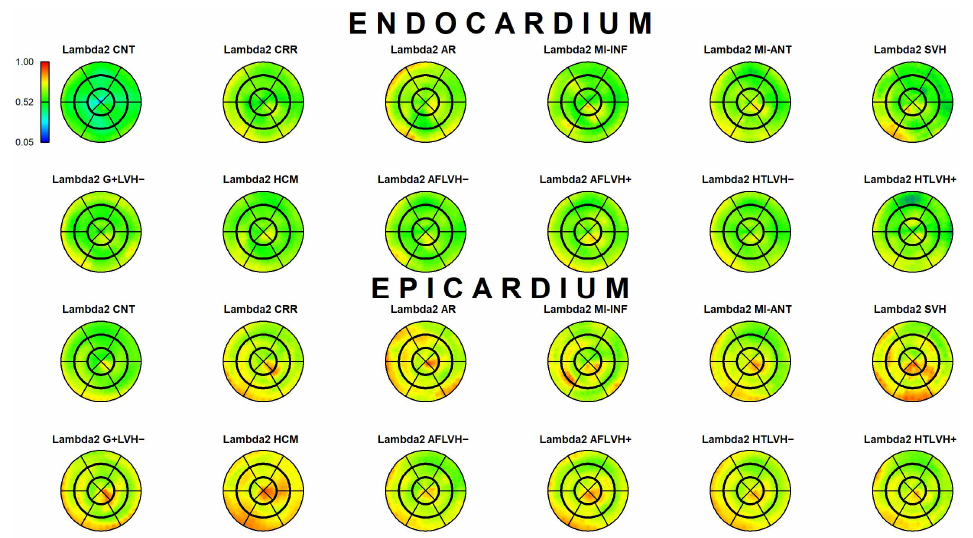
Figure 7. Per-category and per-landmark median values of λ 2 p for both Epi- and Endocardium. Regions are colored according to the color bar at top left. Abbreviations: Control healthy subjects (CNT), Cirrhosis (CRR), Aortic regurgitation (AR), Myocardial infarction of inferior wall (MI-INF), Myocardial infarction of anterior wall (MI-ANT), Mutation carriers for hypertrophic cardiomyopathy with LV hypertrophy (HCM), Secondary ventricular hypertrophy (SVH), Mutation carriers for hypertrophic cardiomyopathy without LV hypertrophy (G+LVH − ), Atrial fibrillation without ventricular hypertrophy (AFLVH − ), Atrial fibrillation with ventricular hypertrophy (AFLVH+), Hypertension without LV hypertrophy (HTLVH − ), and Hypertension with LV hypertrophy (HTLVH+).